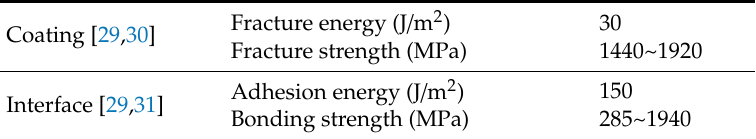
Table 2. Main parameters of cohesive zone model.